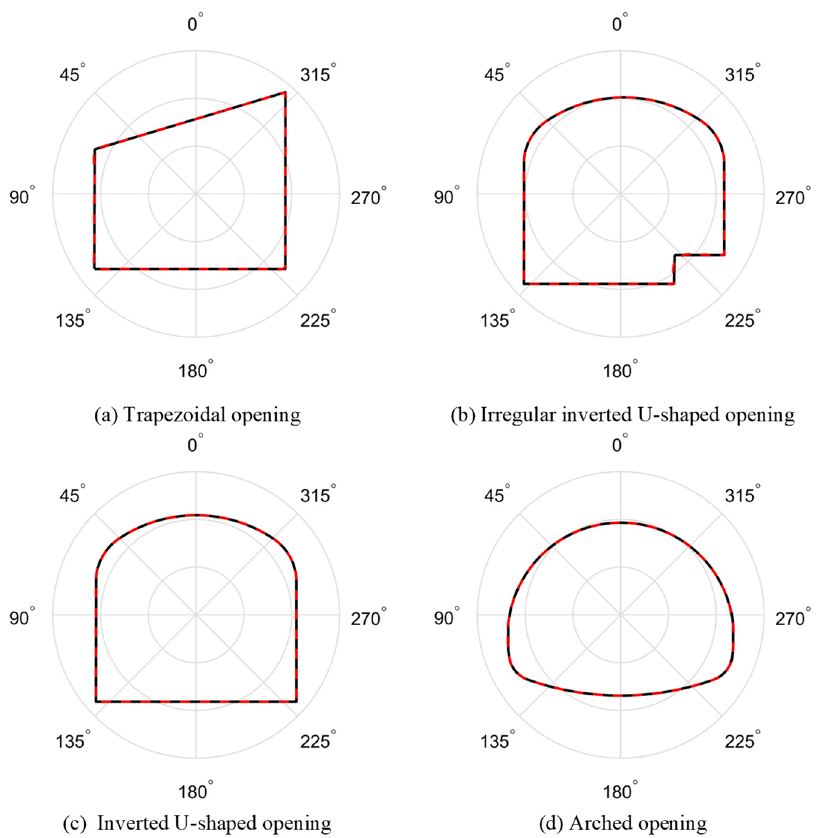
Figure 7. Comparisons between the mapping shape and original shape for different openings (black line indicates the original shape and red line indicates the mapping shape). Table 1. Mapping function parameters of plates with different